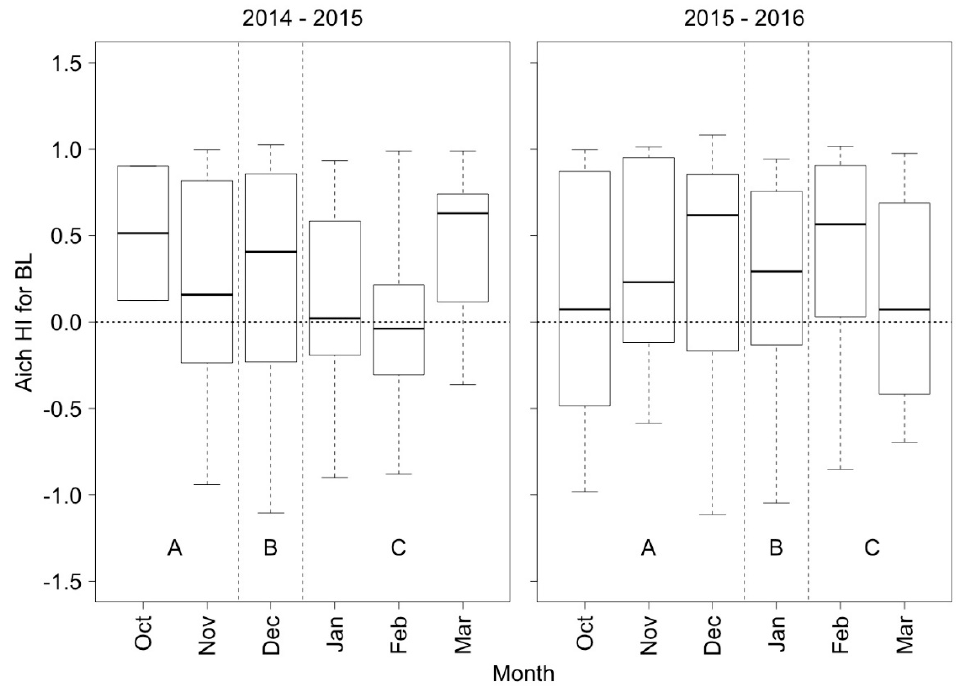
Figure 10. The hysteresis index (calculated following Aich et al. [28]) between water discharge and bedload transport rates grouped by month in the two ablation seasons in the Estero Morales. The main origin of runoff is split in snowmelt ( A ), snow and glacier melting ( B ) and glacier melting ( C ).